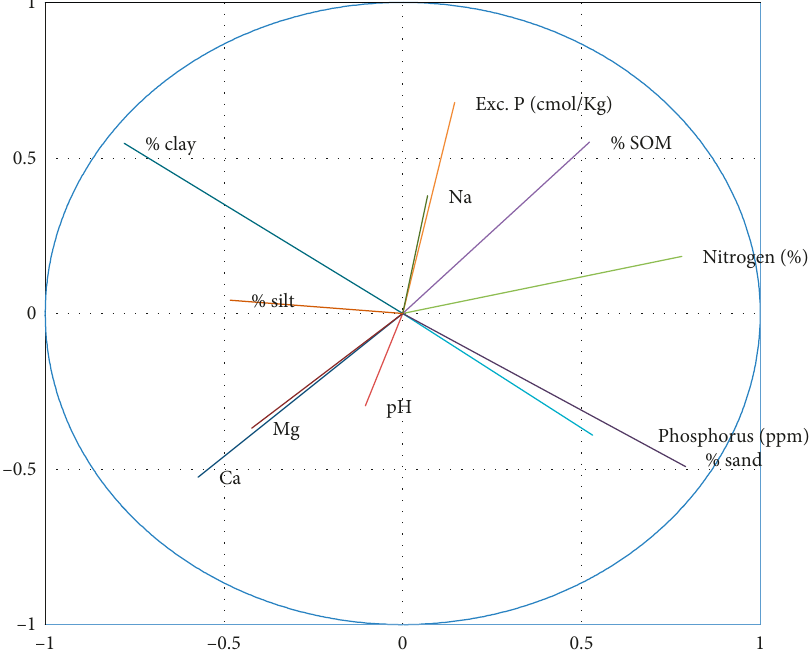
Figure 4: Principal component analysis of the relationship between forage quantity and soil